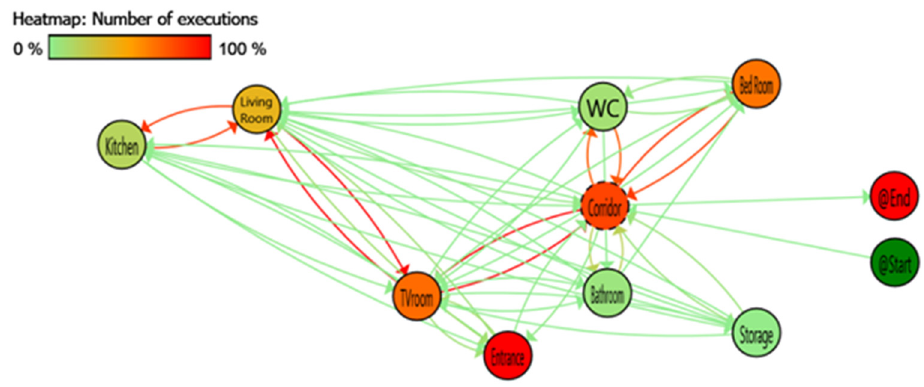
Figure 8. Positioning of PIR sensors and sink node in testbed for re-deployment phase.